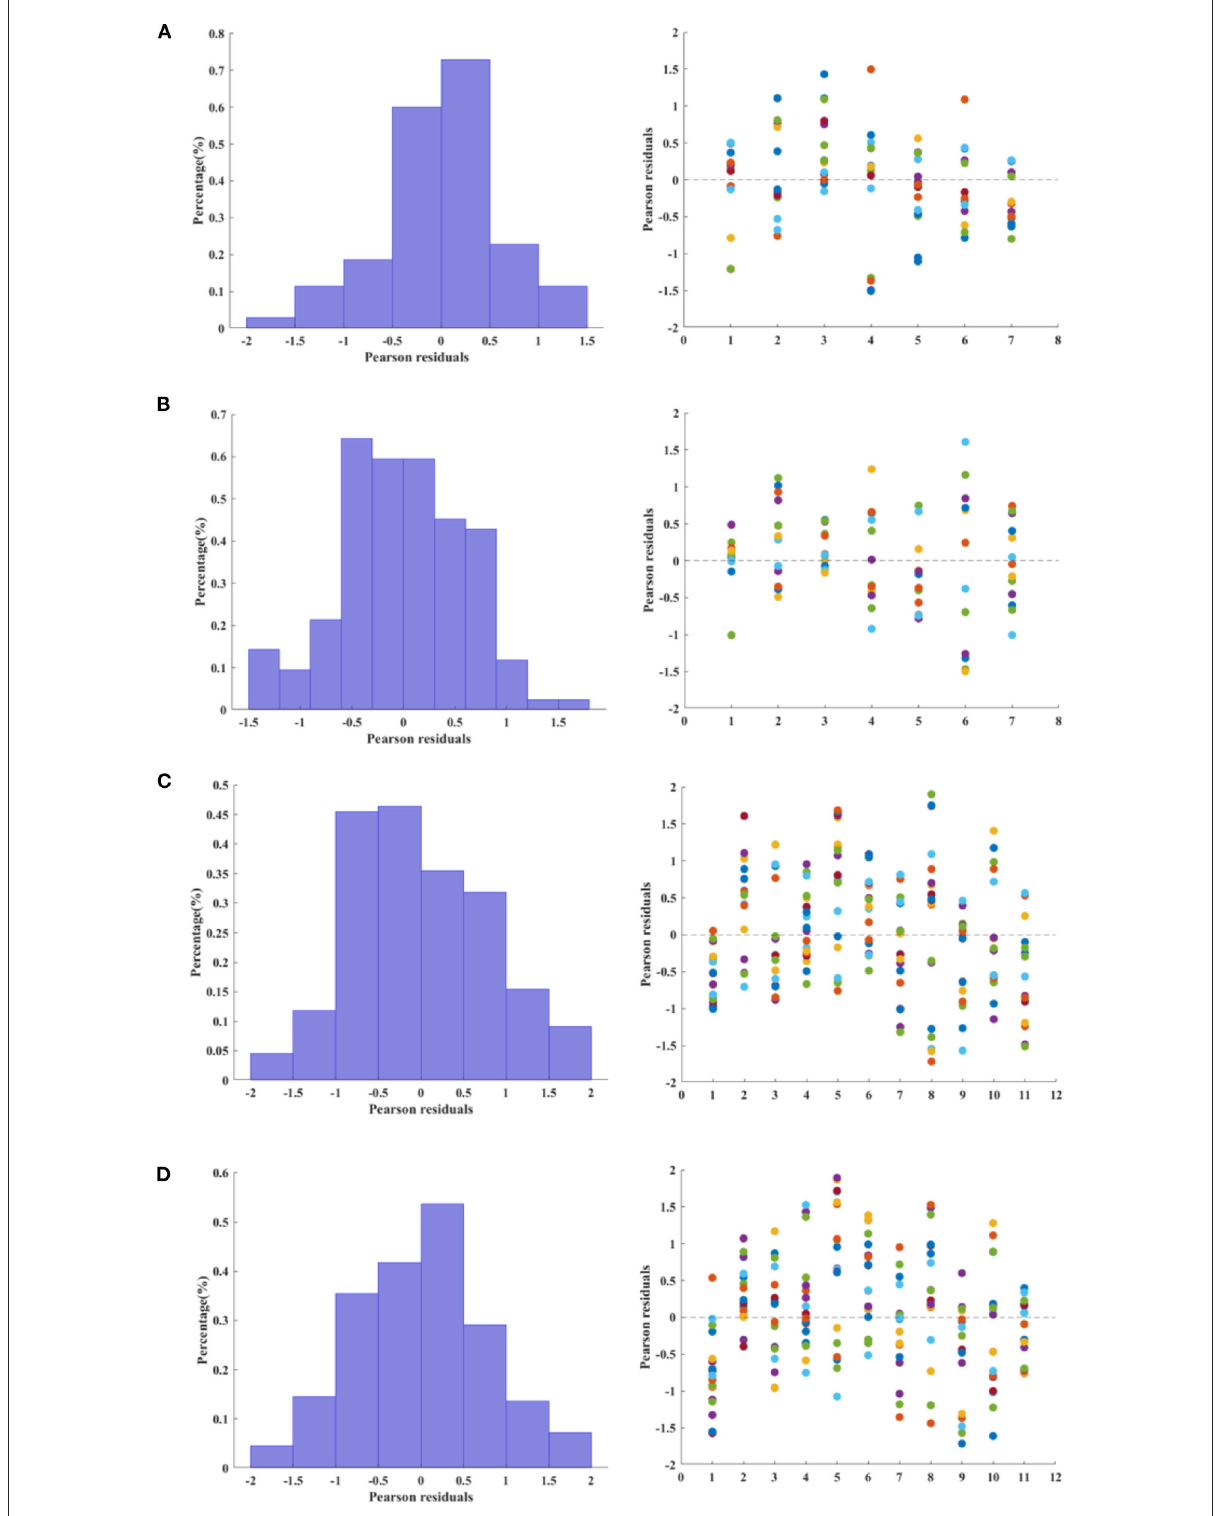
FIGURE3 Relative frequency (left column) and scatter plot (right column) of Pearson residuals estimated from multiple linear regression. For the histograms, the relative frequency was normalized as a probability density function, i.e., the area of each bar is the relative number of residuals observed for a given interval and the sum of the bar areas is less than or equal to one. (A,B) Control group, left and right hemisphere, respectively. (C,D) . Refractory epilepsy group, left and right hemisphere,